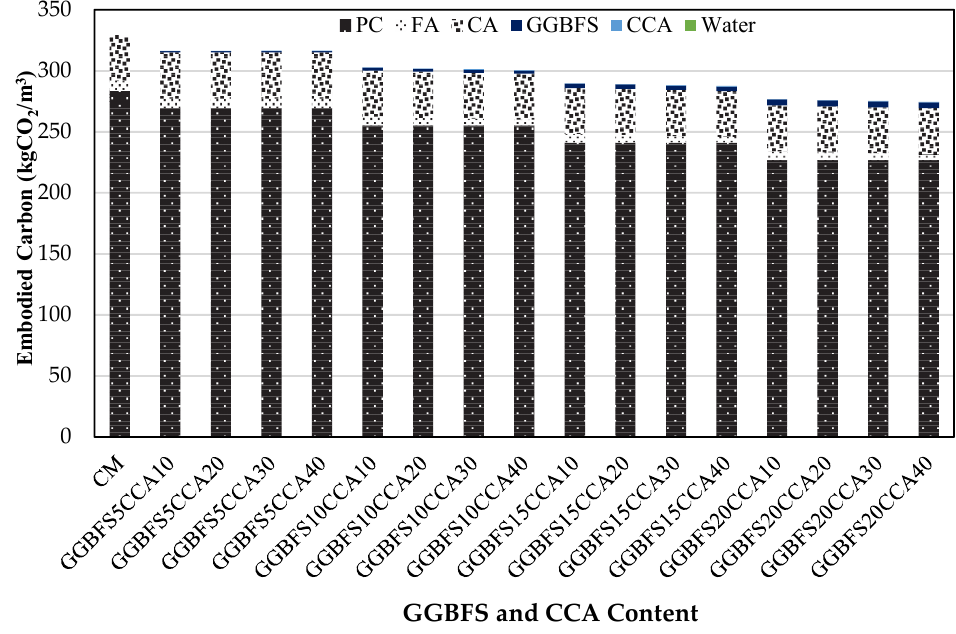
Figure 17. Embodied carbon of concrete blended with GGBFS along with CCA.